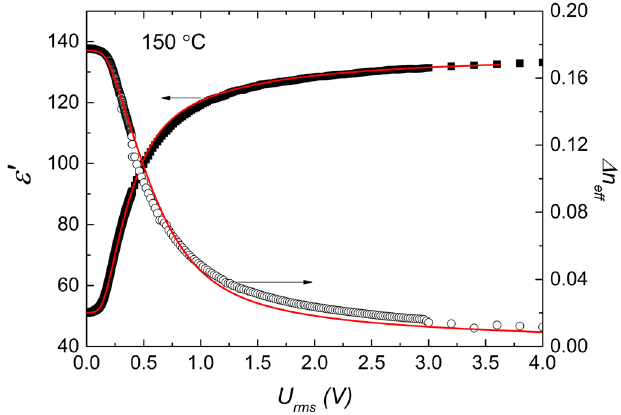
FIG. 8. Dielectric (full squares) and optical (empty circles) Fredericks transition at 150 °C and 10 kHz. The lines are the